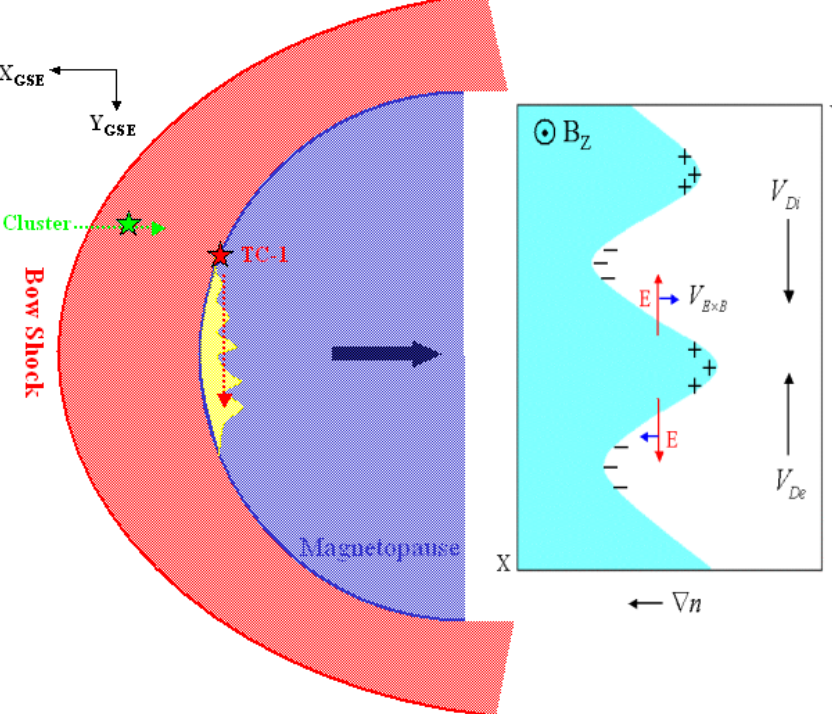
Fig. 2. A schematic of the geographical locations of the Cluster and TC-1 spacecraft projected to the ecliptic plane. The bow shock and the magnetopause are shown by the red and blue bows respectively. The green and red stars and the dashed arrows denote the Cluster and TC-1 spacecraft and their orbits respectively. The ripples at the magnetopause describe the scenario of the drift instability. Meanwhile, its fundamental physical picture is illustrated at the right side. A sinusoidal electrostatic potential perturbation tight ties to a sinusoidal plasma density perturbation, and both them propagate with the plasma diamagnetic drift velocity. For more details see the